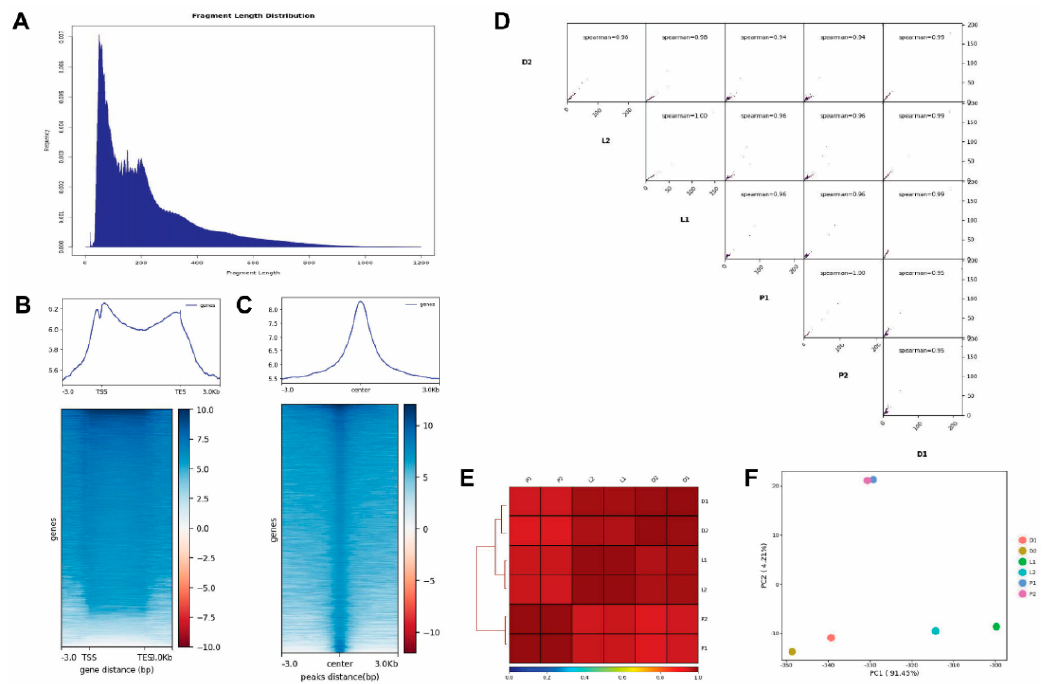
Figure 1. Results of the assay for transposase accessible chromatin by sequencing (ATAC-seq). ( A ) Fragment length distribution map. ( B , C ) Mapped reads distributions (from bigwig) across gene bodies and peaks. The X-axis represents the normalized gene or peak length, and the Y-axis represents the read enrichment. The larger the value, the more enriched. TSS stands for the gene start site, and TES stands for the gene stop site. − 3.0 represents 3 kb upstream of TSS, and 3.0 kb represents 3 kb downstream of TES. ATAC-seq read distributions are presented as an average plot (up) and heatmap (down). The Deeptools tool was used for this analysis. ( D ) The Pearson correlation results shown by heatmap scatterplot. ( E ) The Pearson correlation results shown by heatmap. ( F ) Principal Components Analysis (PCA) plot.